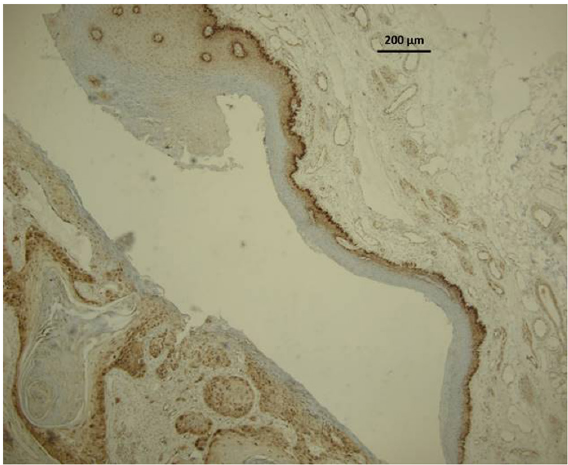
Figure 5. More intense expression in the basal layer of the adjacent epithelium and the periphery of tumor solid